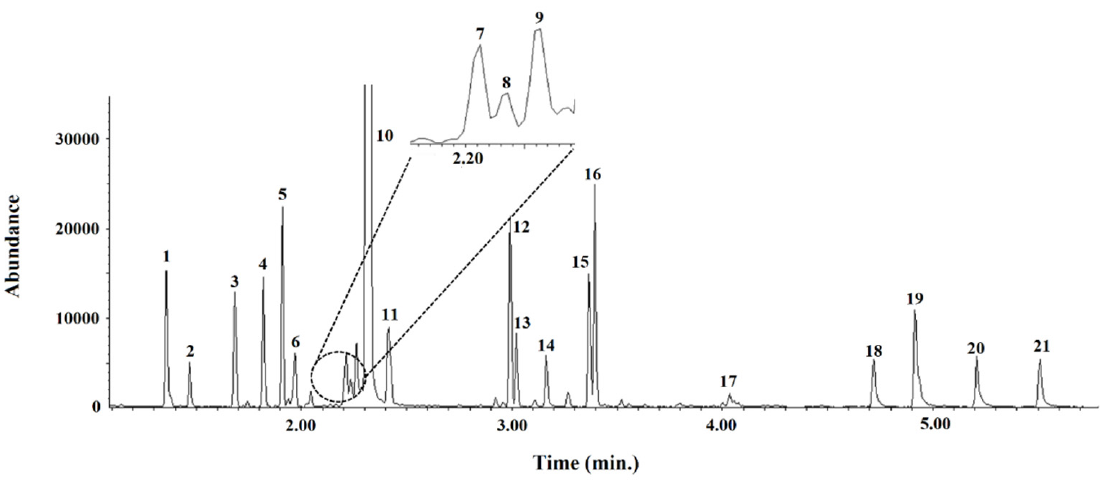
Figure 2. Representative chromatogram (total ion chromatogram (TIC) mode using the quantification ions; see Table 1) obtained from a standard in solvent mixture of free amino acids. The GC-MS conditions are summarized in Section 2.4.1 and Table 1. 1, ALA; 2, GLY; 3, VAL; 4, NVAL (IS); 5,